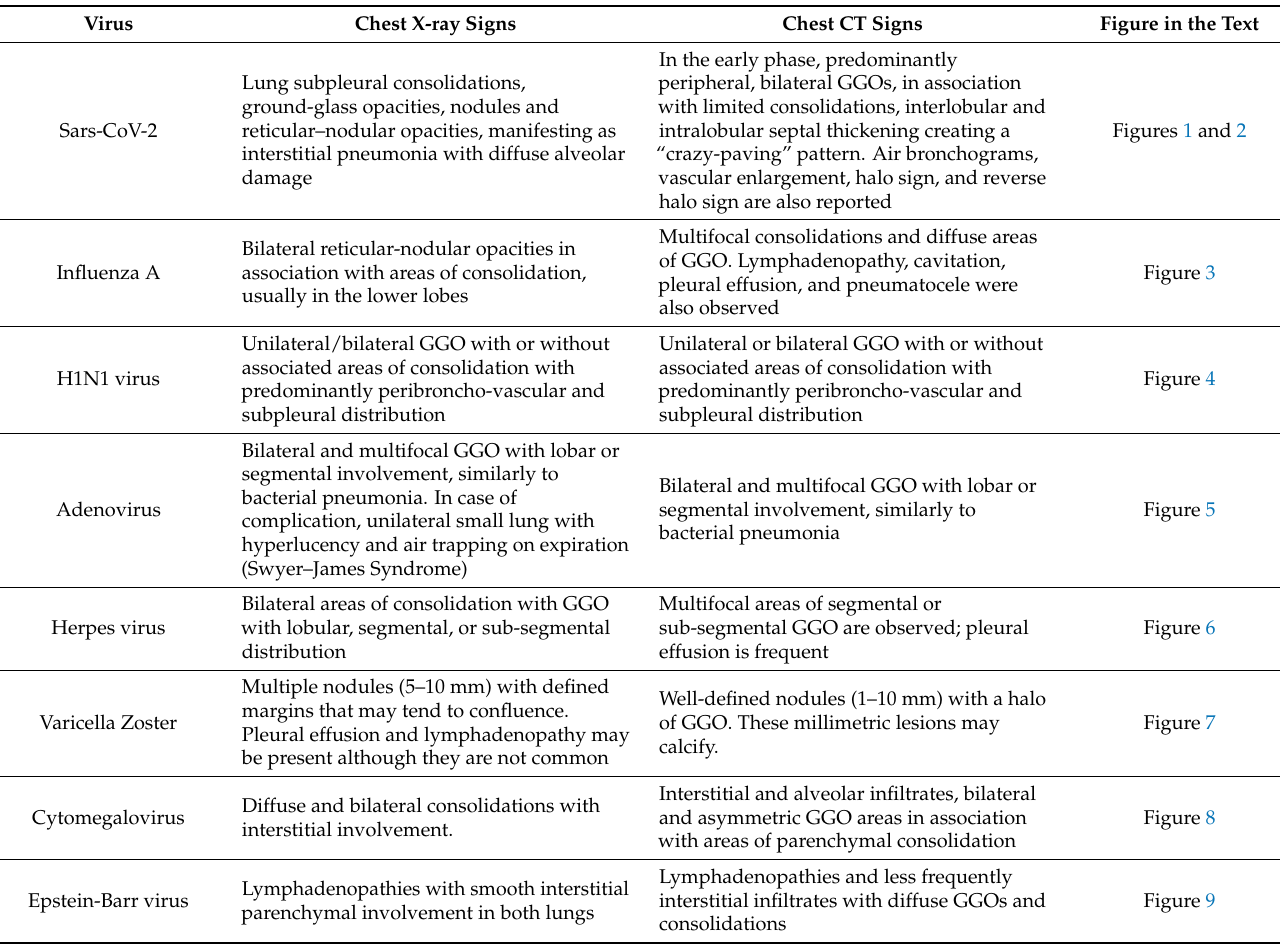
Table 1. Summary table with the main CXR and chest CT features of the viruses explained in the following figures in this review. CT: computed tomography; GGO: ground-glass